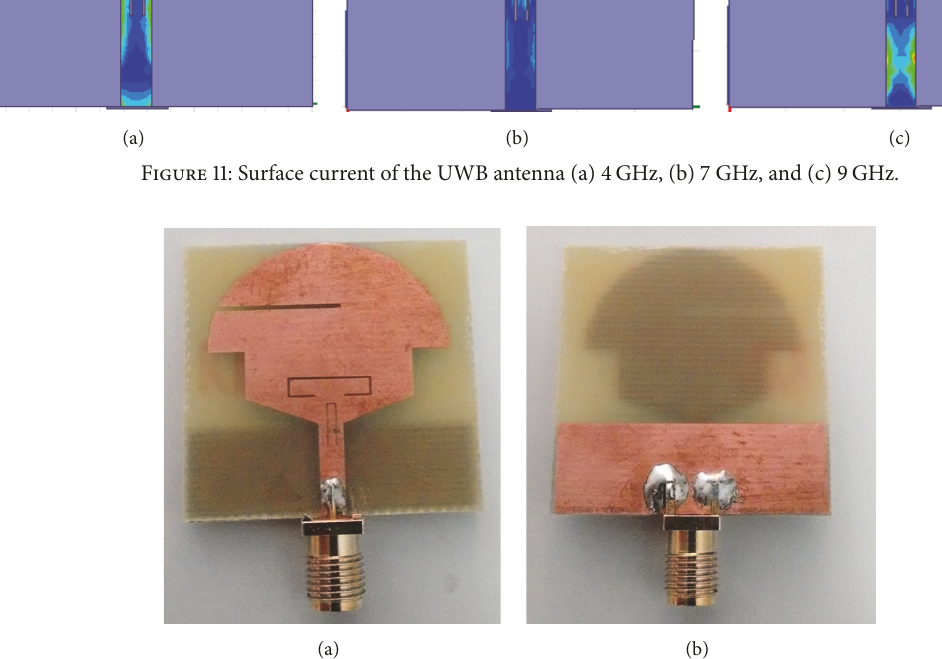
Figure 12: Photographic image of the fabricated of the UWB antenna. (a) Top view and (b) back view.